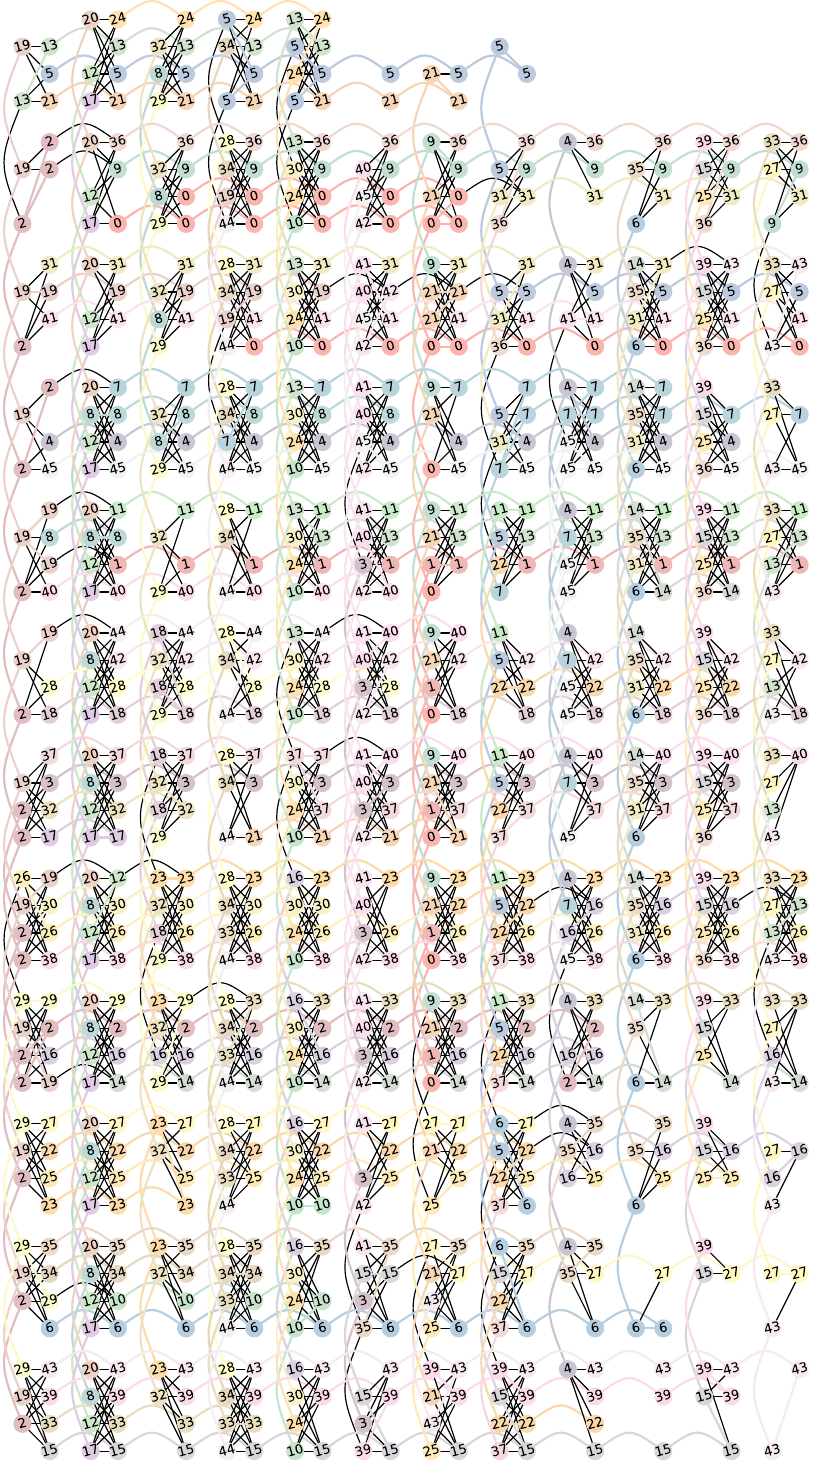
FIG. 8. Embedding. We show 46 logical variables embedded into DW2X ’ s chimera graph using 940 physical variables. Qubits belonging to a logical variable are identified by the same number and linked by edges of the same color. This embedding uses 86% of DW2X ’ s